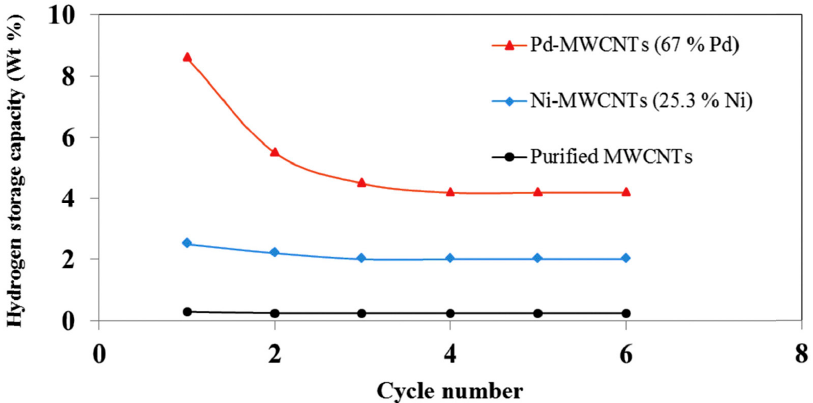
Figure 6. Reduction of gravimetric density of decorated MWCNTs within consecutive cycles of sorption/desorption. Reproduced with permission from Mehrabi et al., International Journal of Hydrogen Energy; published by Elsevier 2018.